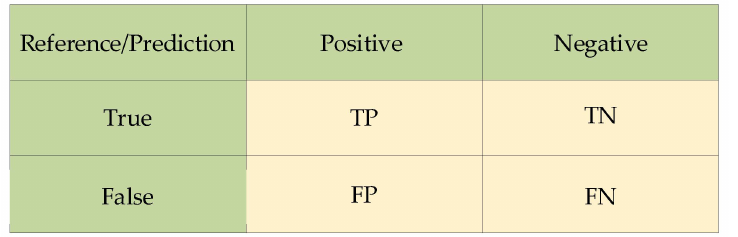
Figure 12. Confusion